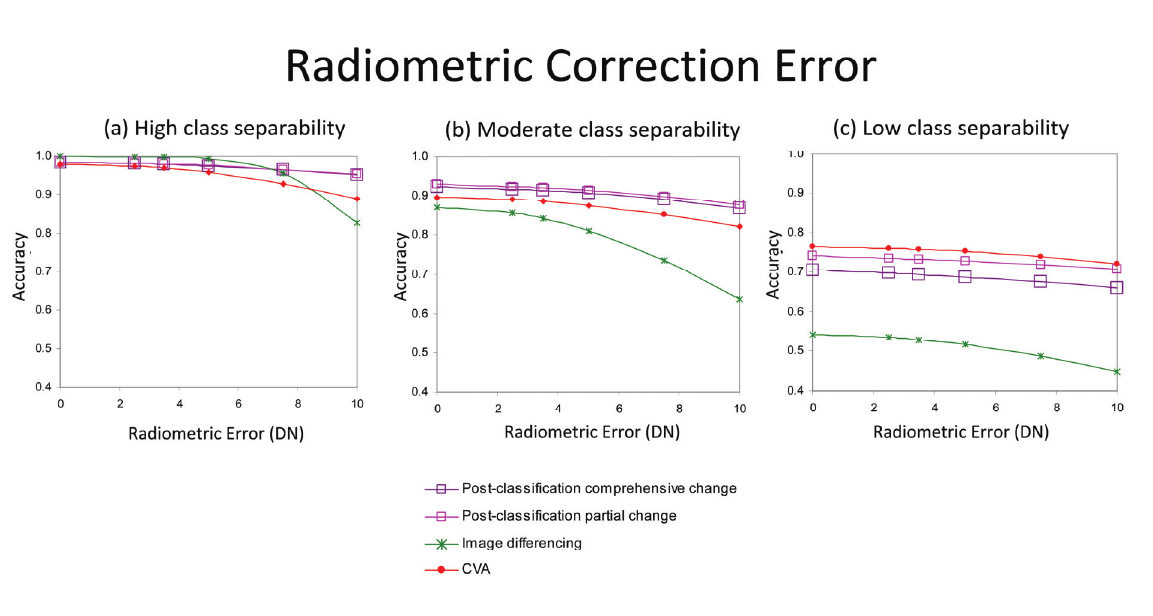
Figure 7. Effect of radiometric normalization error on accuracy of change analysis methods, for simulated classes with high, moderate and low